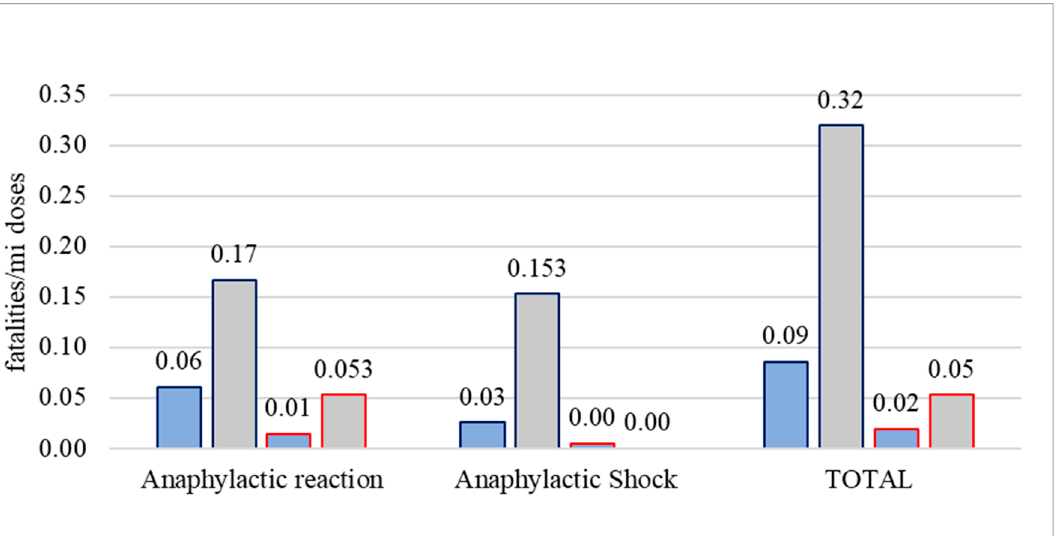
Figure 3. Rates of estimated anaphylactic reaction and anaphylactic shock fatalities post-COVID-19- vaccination for mRNA (blue bars) or vectored (grey bars) vaccines, as reported by EudraVigilance (dark blue lining) and the VAERS (red lining) databases, expressed per million administered doses from week 52, 2020 to week 2, 2023 for EudraVigilance and week 1, 2023 for the